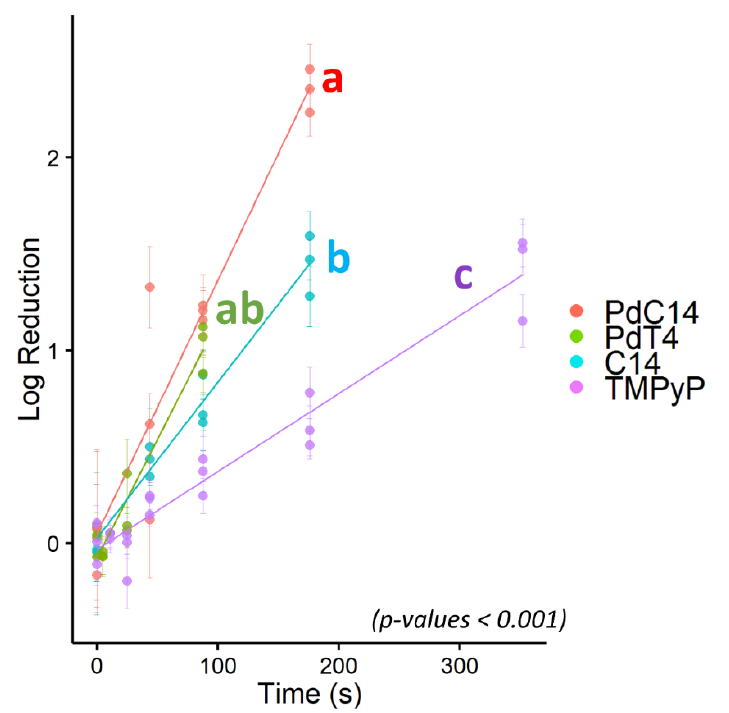
Figure 3. Log 10 reduction of bacteriophage Φ X174 via blue-light photodynamic inactivation medi- ated by four porphyrins: PdC14, PdT4, C14, and TMPyP. All points represent single experimental replicates (mean of 10 plaque counts) and error bars represent ± 1 standard deviation of measurement. Porphyrins with statistically distinct inactivation rates are indicated by different letters, where PdT4 (“ab”) was not distinct from either PdC14 (“a”) or C14 (“b”). PdT4, C14, and PdC14 were distinct from TMPyP (“c”). p < 0.001.